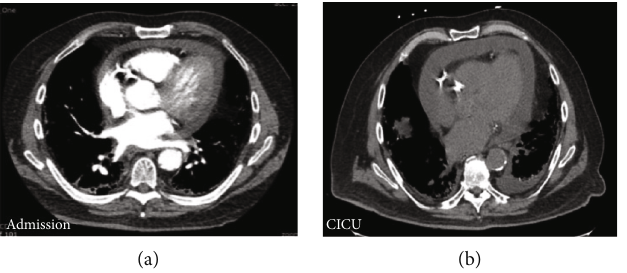
Figure 1: CT chest on hospital day 1 (a) and hospital day 7 (b). The pericardial e ff usion had expanded from a largest diameter of 1.5cm (a) to 2.0cm (b) along with increase in left pleural e ff